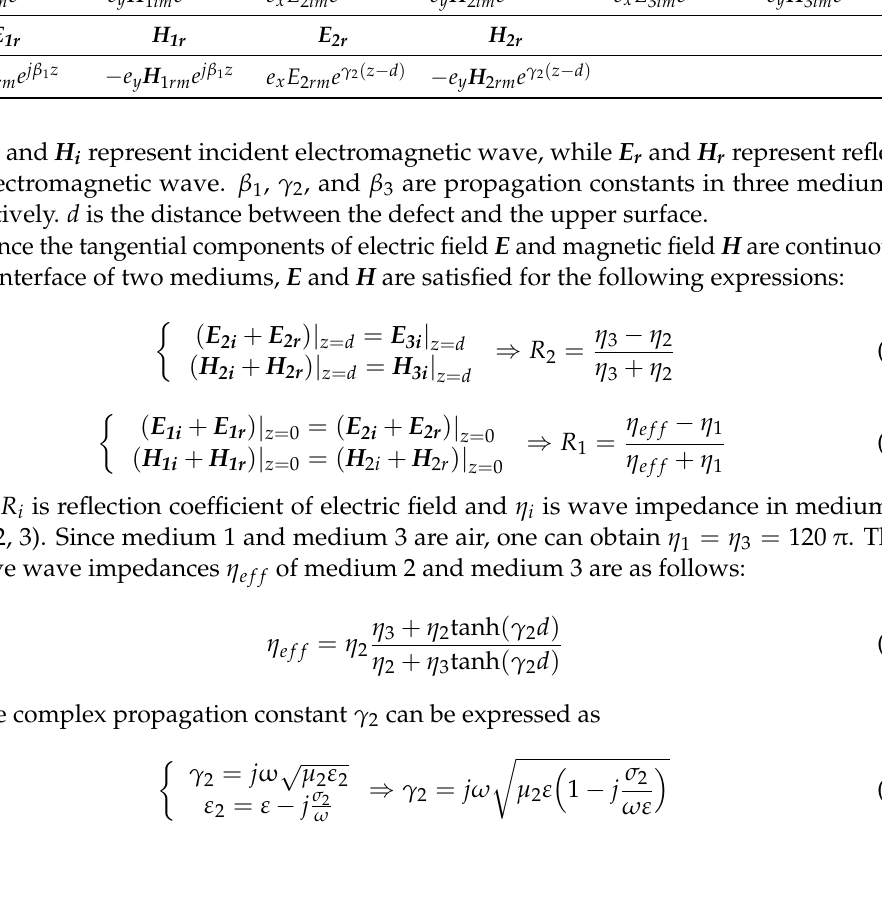
Table 1. Expressions of electromagnetic field.